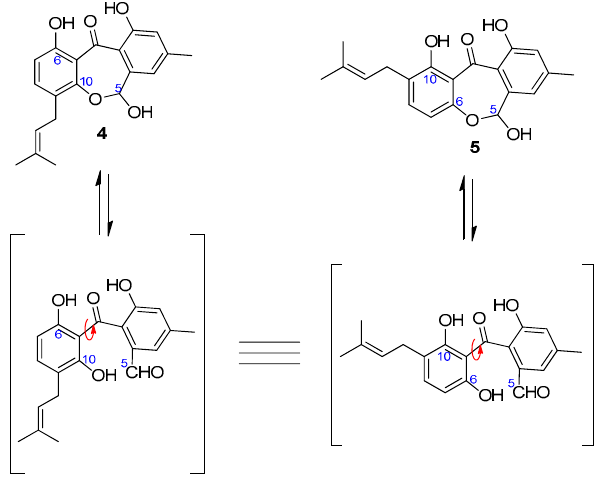
Figure 7. The interconversion of 4 and 5 .